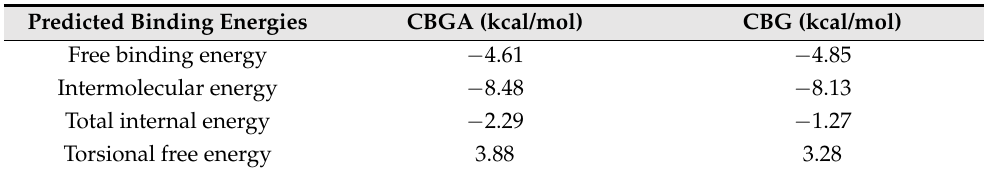
Table 3. Binding energies between CBGA or CBG and the M pro protein predicted by the molecular docking experiments.